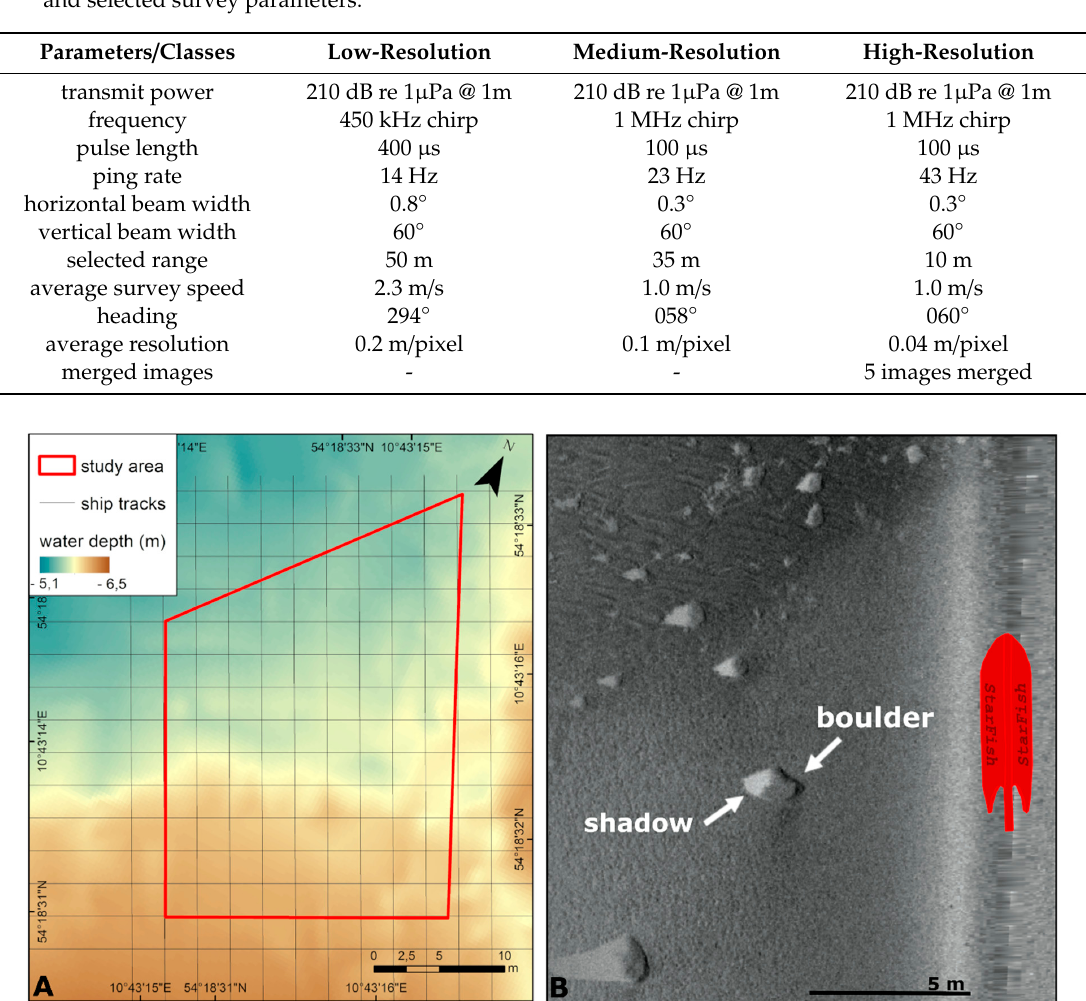
Figure 2. ( A ): Grid of the executed ship tracks along the study area. Red lines enclose the study area. Along the red lines, SSS images were generated with a range of 35 m. The black lines display the ship tracks, along which the surveying was done with a range of 10 m and spacing between the track lines of 2.5 m. ( B ): Individual boulders can be clearly identified by their high backscatter intensities combined with their characteristic shadows.